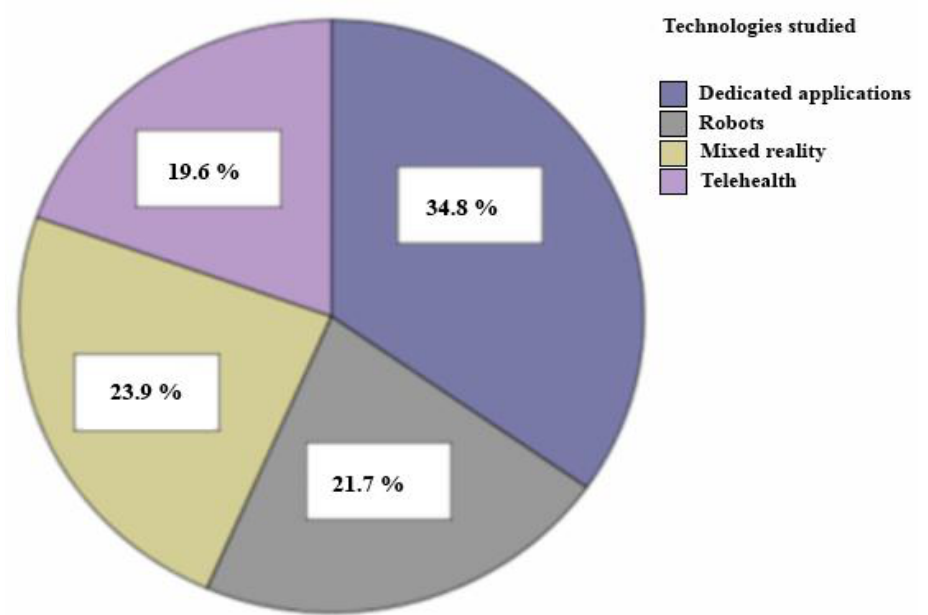
Figure 5. Summary of the technologies reviewed.